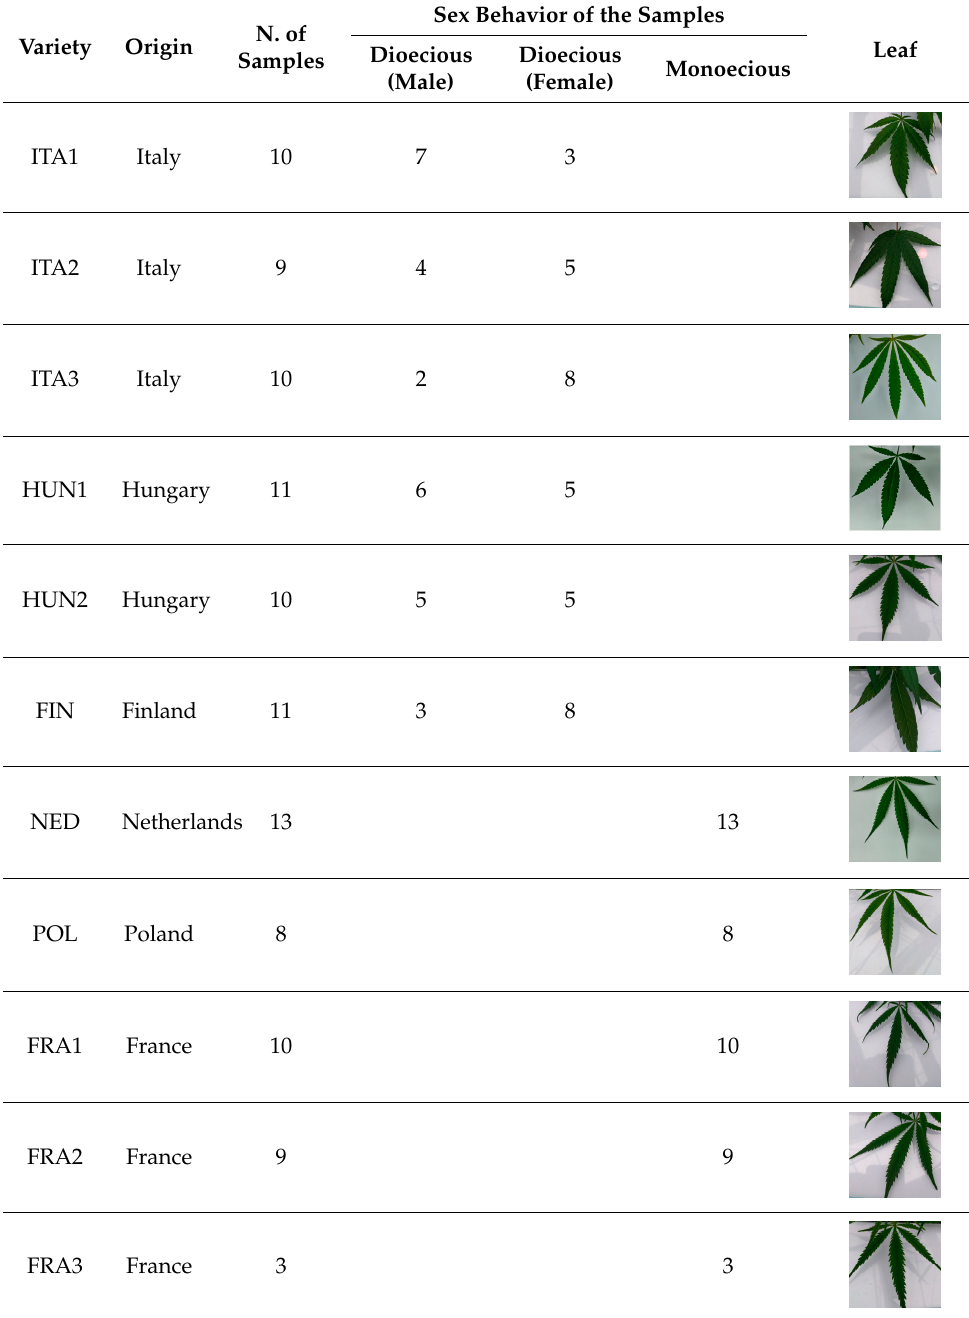
Table 4. Detailed information of the 104 samples analyzed in this study. The name of each variety, the geographical origin, the number of samples and the sex behavior are reported along with a representative picture of the leaf morphology.